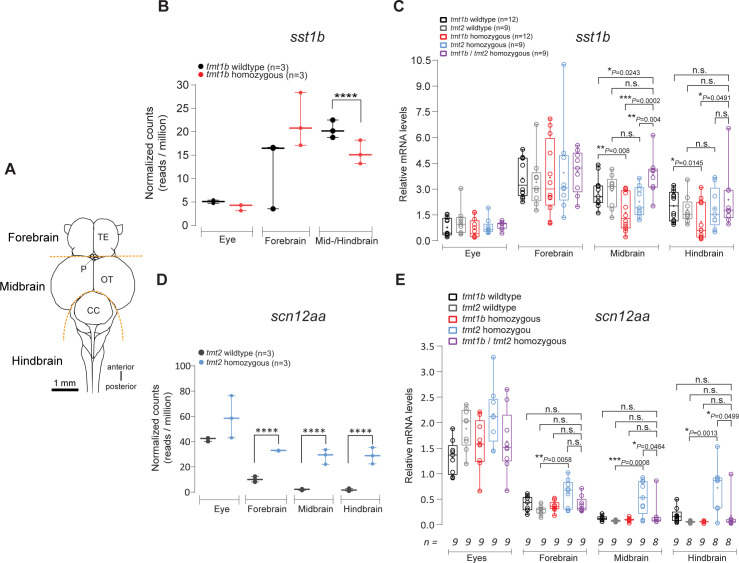
Ola-tmt-opsin1b/2 double mutants are compensated for differential transcript changes present in Ola-tmt-opsin1b and Ola-tmt-opsin2 single mutants.(A) Schematic drawing of the adult medaka brain in dorsal view. Dotted lines indicate the dissection boundaries (TE: telencephalon; P: pineal organ; OT: optic tectum; CC: corpus cerebelli). Note: part of the posterior hypothalamus is dissected with the midbrain, as it is attached to its ventral part and technically unfeasible to reliably separate. (B) Normalized transcript read counts (****adjusted P value < 0.0001) for sst1b. (C) mRNA transcript levels for sst1b determined by quantitative PCR in brain areas and eyes of tmt-opsin1b (tmt1b) mutant, tmt-opsin2 (tmt2) mutant, and corresponding wild-type and double-mutant fish. Decreased sst1b levels are unique to tmt-opsin1b−/− mutants and are compensated by the tmt-opsin2−/− mutant. *P ≤ 0.05; **P ≤ 0.01; ***P ≤ 0.001; n.s.: no significance. (D) Normalized transcript read counts (****adjusted P value < 0.001) for scn12aa. (E) mRNA transcript levels for scn12aa in brain areas and eyes. Increased levels of scn12aa are unique to tmt-opsin2−/− mutants, and compensated for when both tmt-opsin1b and tmt-opsin2 are jointly mutated. *P ≤ 0.05; **P ≤ 0.01; ***P ≤ 0.001; n.s.: no significance. Box plots: single bar: median; box: first and third quartile; whiskers: minimum and maximum; each displayed data point corresponds to 1 individual biological replicate. Metadata: S5 Data, S10 Data, S11 Data.